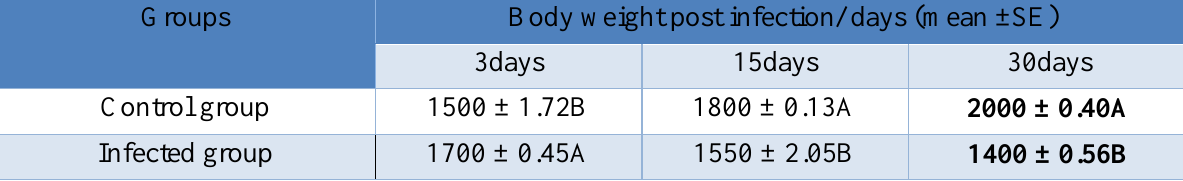
Table, 1: Effect of E.coli infection on body weight (g) of infected group compared with control group at 3, 15 and 30 days post infection.